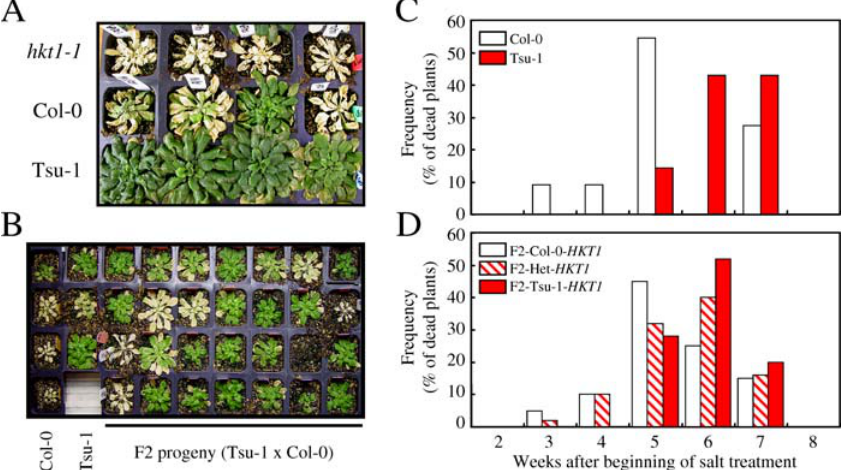
Figure 7. Contribution of Tsu-1 HKT1 Allele to Survival Under NaCl Stress (A) Relative NaCl tolerance of hkt1–1 , Col-0, and Tsu-1. Five-week-old hkt1–1 , Col-0, and Tsu-1 plants were treated biweekly with 100 mM NaCl. Picture was taken 6 wk after beginning of the salt treatment. (B) NaCl tolerance of F2 plants from a Tsu-1 3 Col-0 cross. Picture of one of four plant growth trays used in the experiment. Each tray includes plants from each parent (Col-0 and Tsu-1) as well as F2 plants. (C) Distribution of the parental lines Col-0 ( n ¼ 11) and Tsu-1 ( n ¼ 14) recorded dead each week after beginning of the salt treatment. Presented data are percentage of plants dead each week after beginning of salt treatment. (D) Distribution of F2 plants (Tsu-1 3 Col-0, n ¼ 95) genotyped as Col-0 homozygous or Tsu-1 homozygous or heterozygous for the HKT1 allele and recorded dead each week after beginning of the salt treatment. Presented data are percentage of plants dead each week after beginning of